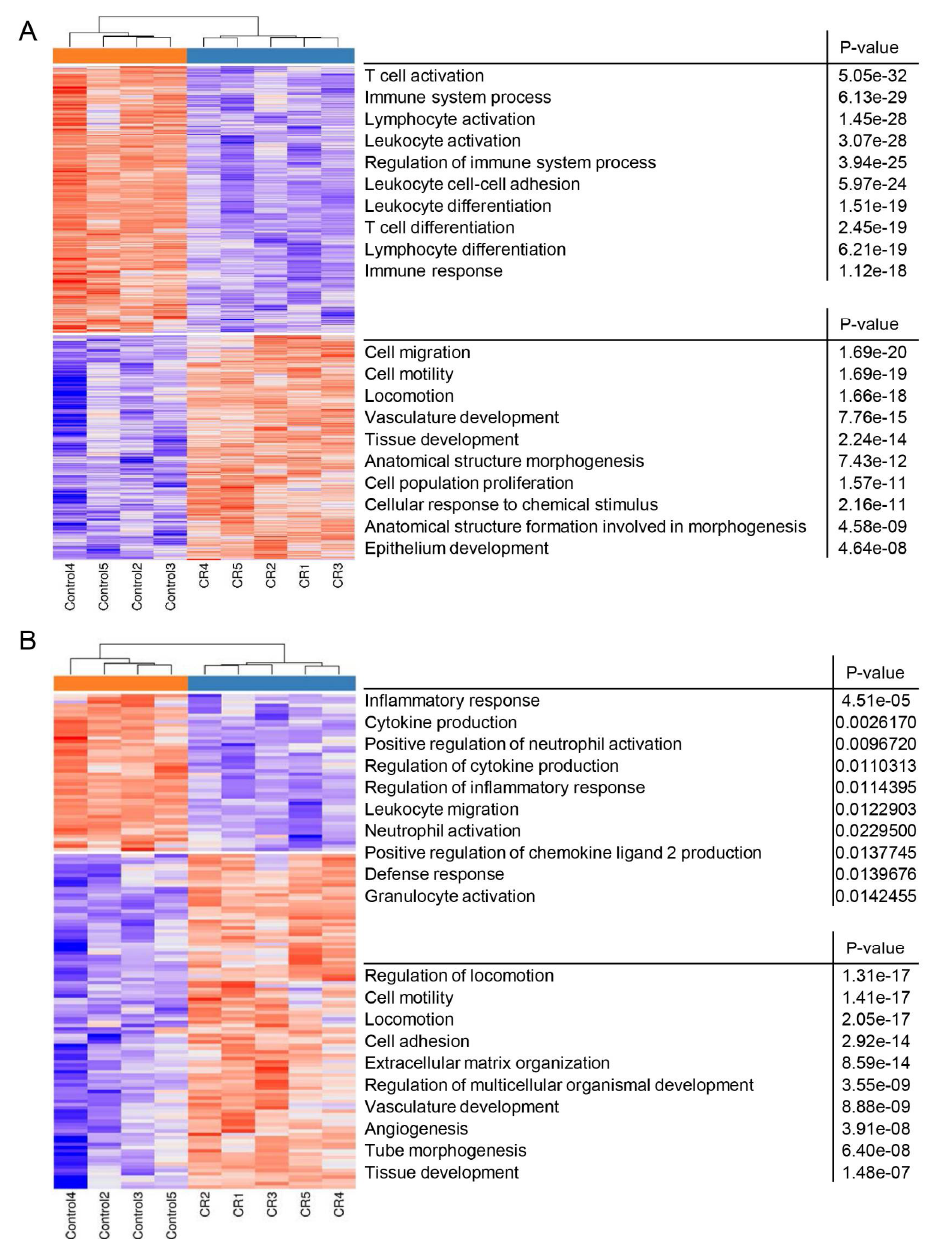
Figure 3. Heatmap and GO analysis presenting enriched biological activities affected by differentially expressed genes in non-epithelial mammary cells derived from ad libitum-fed and calorie restriction (CR)-treated mice. ( A ) Heatmap of all differentially expressed genes. ( B ) Heatmap of differentially expressed genes encoding secreted proteins. Criteria of ≥ 1.5-fold change, adjusted p ≤ 0.05 and minimum 30 counts in at least one of the samples was applied to distinguish the CR effect.